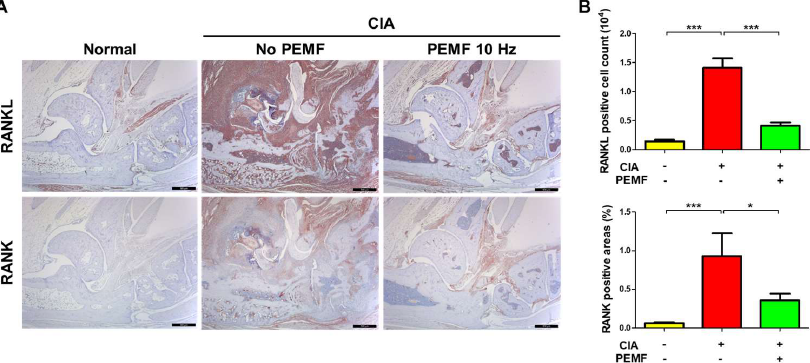
Figure 6. Effects of PEMF (10 Hz) on RANKL and RANK levels in ankle joint tissues. ( A ) Immuno- histochemical staining of RANKL and RANK in ankle joint paraffin sections. The magnification is × 40. Bar, 500 µ m. ( B ) The percentage of RANKL-positive cells and RANK-positive tissue. Data are presented as the mean ± SEM. Normal, n = 7; CIA, n = 6; CIA+PEMF 10 Hz, n = 10. Significance was measured using a two-tailed Student’s t -test (* p < 0.05 and *** p < 0.001).